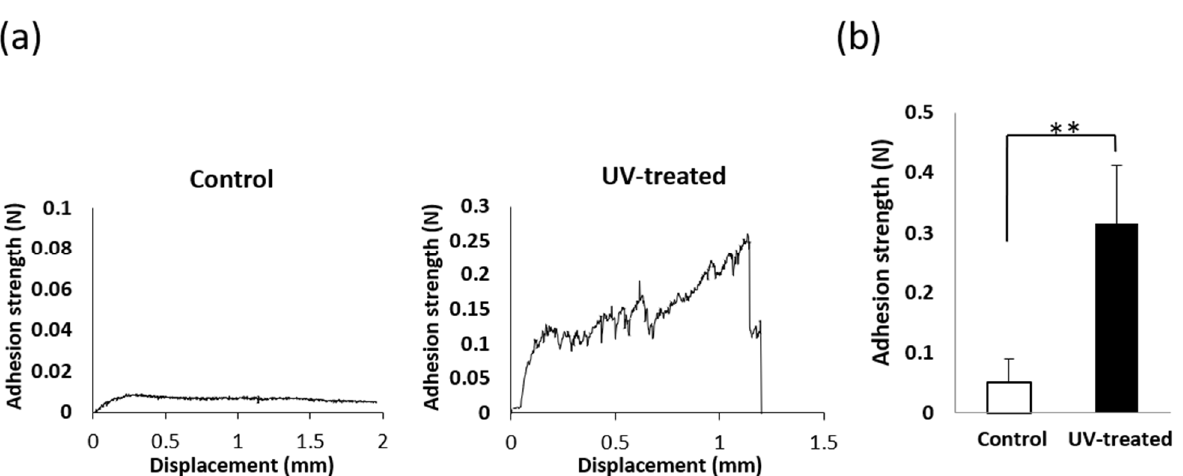
Figure 3. ( a ) Load–displacement curve obtained during pulling of mucosa connective tissue until detachment on control disk and UV-treated disk. The maximum load for the control disk and the break point for the UV-treated disk were recorded as adhesion strength. ( b ) Adhesion strength of mucosa connective tissue. Data are mean ± SD ( n = 10). ** p < 0.01, statistically significant difference between the control and UV-treated surfaces.